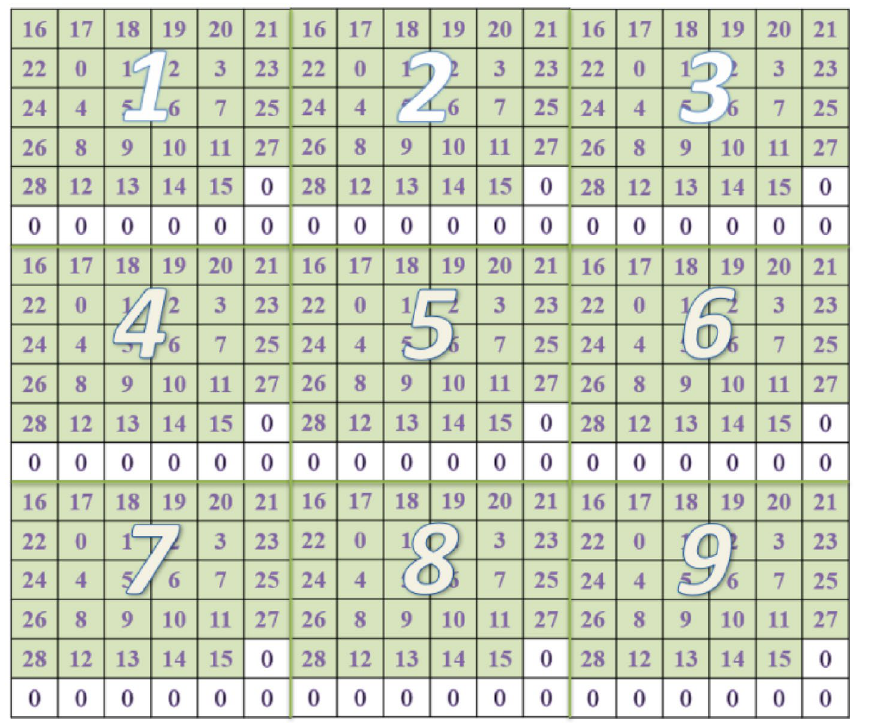
Figure 7. Results of 3*3 Mosaic pattern data arrangement with a 29-bit CAN ID coded in a 6*6